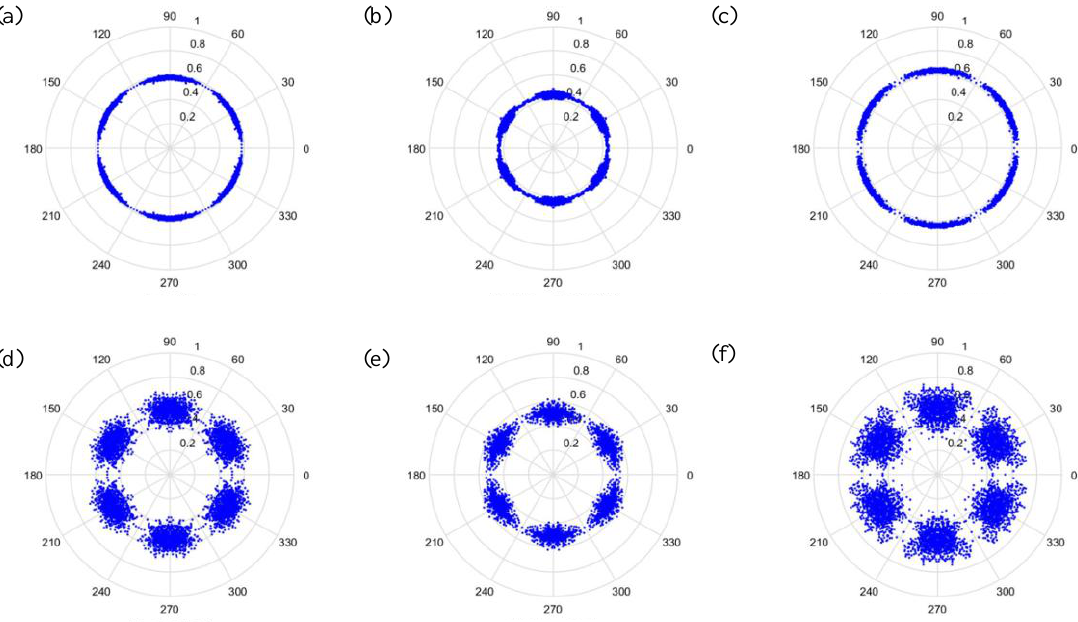
Figure 9. Results by improved formula when t = 1 and sampling is at 1000 Hz / 1000 rpm. ( a ) Normal, ( b ) motor platform with one eccentric screw, ( c ) motor platform with two eccentric screws, ( d ) sanded ball bearings, ( e ) insu ffi cient lubrication, and ( f ) worn ball bearings.